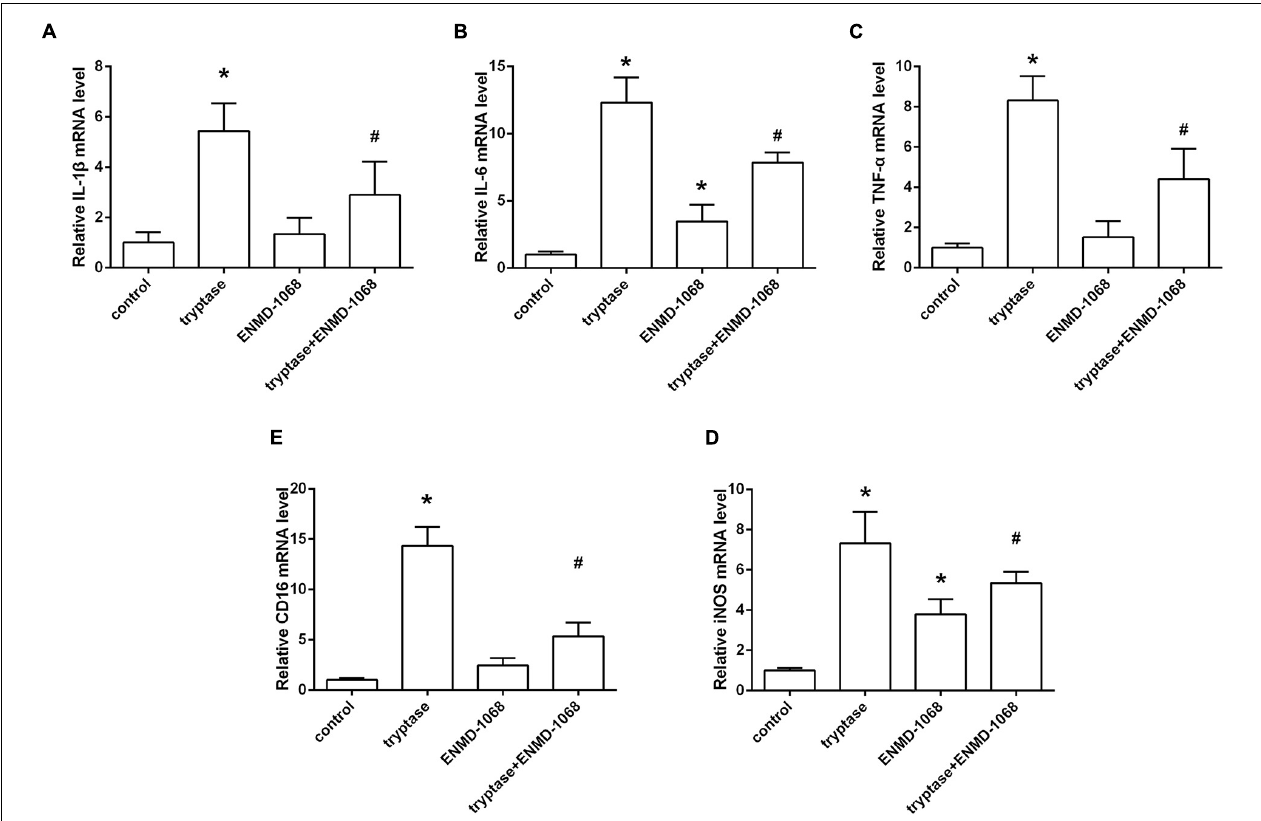
FIGURE 7 | Effect and mechanism studies using cultured BV2 cell in vitro . (A–E) Quantification of RT-PCR on the relative mRNA level of pro-inflammatory cytokines genes (IL-1 β , IL-6, and TNF- α ) and M1 microglia markers genes (CD16, iNOS). Data were represented as mean ± SD. * P < 0.05 versus control group. # P < 0.05 versus tryptase